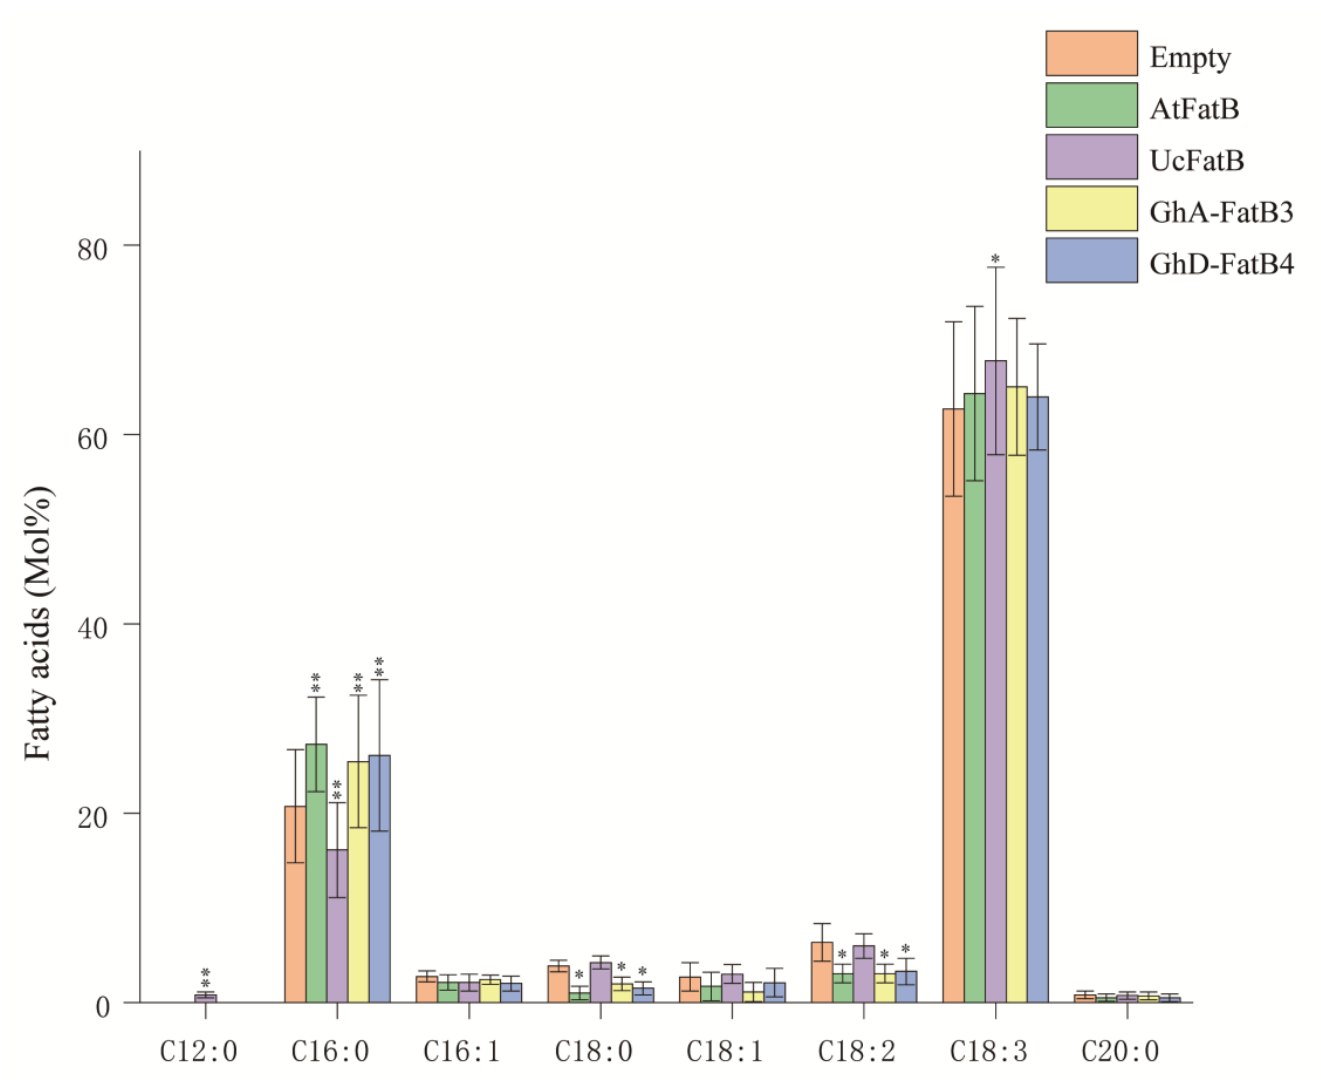
Figure 7. Fatty acid profiles in the N. benthamiana leaves transiently expressing GhA-FatB3 , GhD-FatB4 , AtFatB and UcFatB , respectively. Data are means of mol% ± SE with six biological replicates. “*” and “**” represent statistically significant differences ( p < 0.05 and p < 0.01) based on two-tailed Student’s t tests compared with the negative control (empty vector).